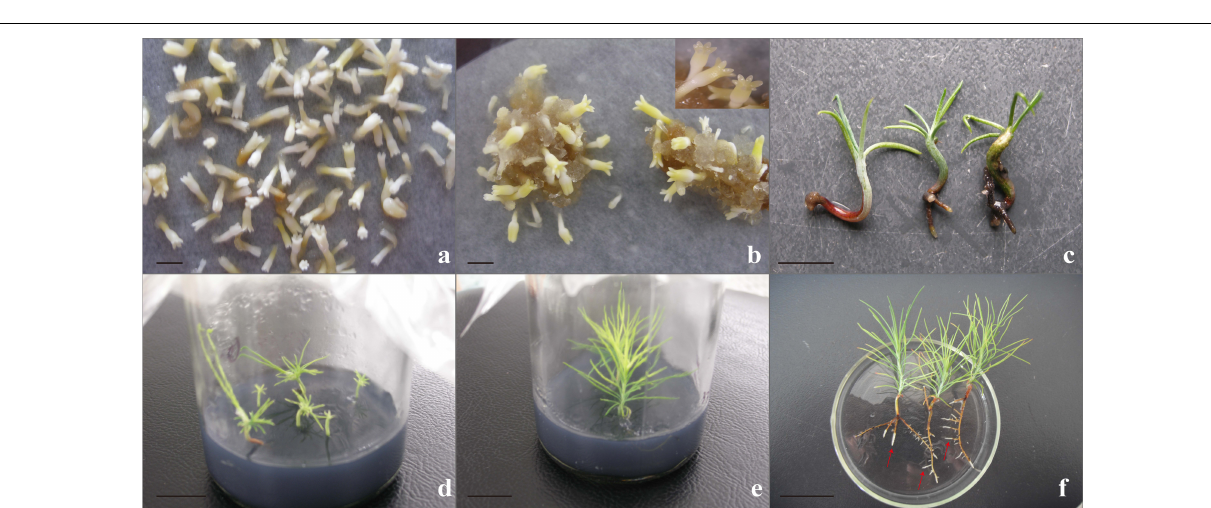
FIGURE 8 | Somatic embryo germinated and conversed to form complete plants. (a,b) Mature somatic embryos cultured for 6–7 weeks; normal, mature cotyledonary embryos were characterized by plump cotyledons and a color of milky white or light yellow; and the number of mature cotyledonary embryos in physiology and morphology accounted for 81.2%; the statistical method was based on the characteristic parameters proposed by Le et al. (2021). (c) Somatic embryo germination for 20 days; the radicle turned red and become the taproot, the cotyledon turned green, hypocotyls elongated. (d) Somatic embryo plantlet on rooting medium for 30 days. (e) Intact somatic embryo-derived plant 4–5 cm in height with 2–3 roots when subcultured for 3–4 cycles. (f) New roots (red arrowheads) grew when cultured for 3 days in the nutrient solution. Scale bar = 1 cm.